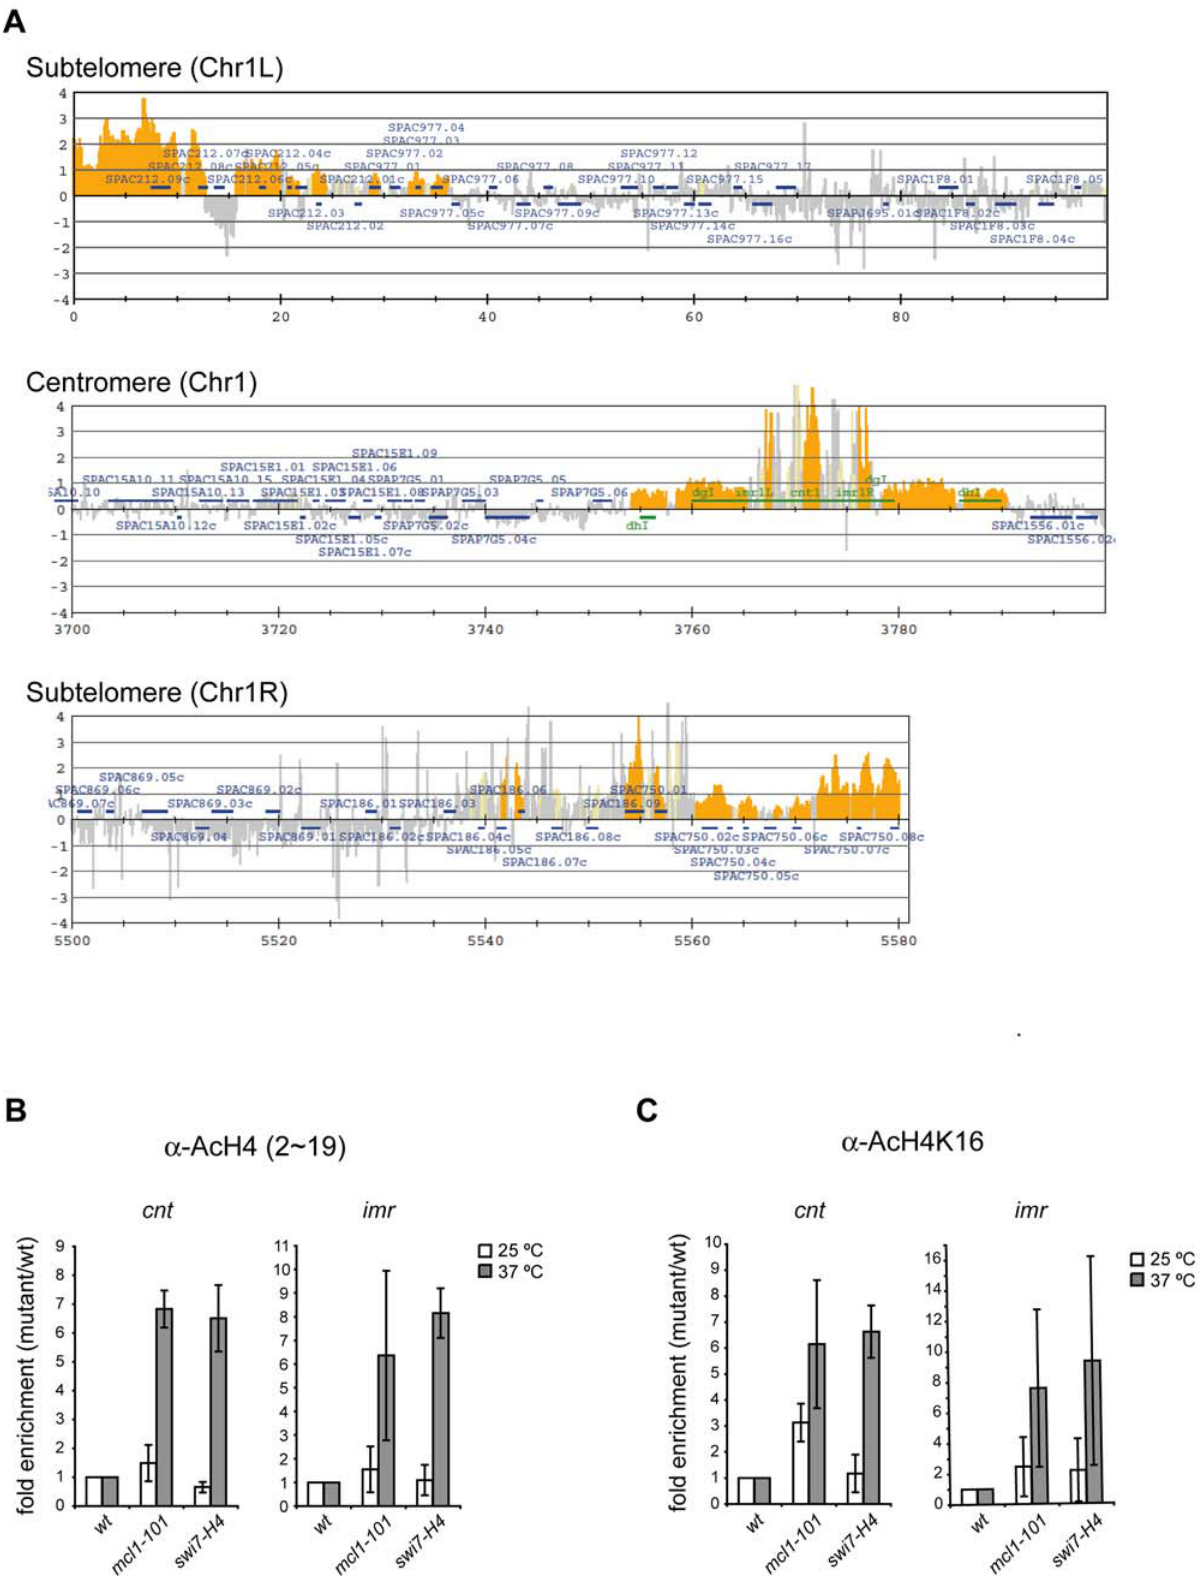
Figure 5. Acetylation of histone H4 is aberrantly increased in the central kinetochore domain in mcl1 and swi7 mutants. ( A ) ChIP-on- chip was performed using the antiserum raised to a peptide corresponding to amino acid 2–19 of histone H4 that is acetylated at K5, K8, K12, and K16 (AcH4-KN). The cells were prepared as described in Figure 4C. Values obtained from AcH4-KN in the mcl1 mutant were divided by those in wild-type